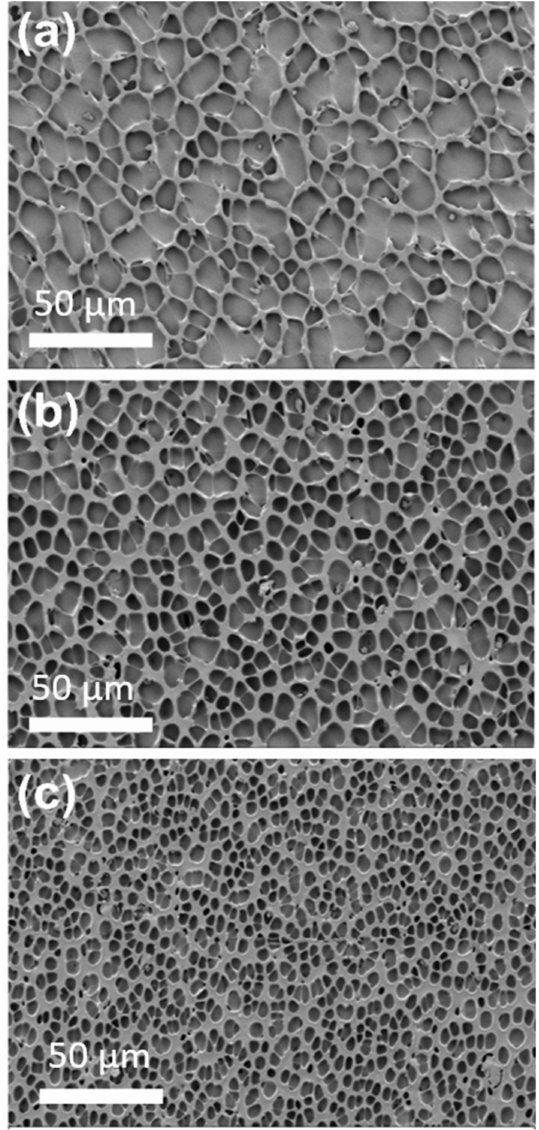
Figure 1. Scanning electron microscopy (SEM) images of ( a ) drug-free PU, ( b ) 1.92% w / w DTX- loaded and ( c ) 2.79% w / w DTX-loaded stents. The cavity sizes for the drug-free, 1.92 and 2.79% w / w DTX-loaded stents sections were 12.6 ± 4.6, 8.4 ± 2.1 and 4.9 ± 1.6 µ m ( n = 50),